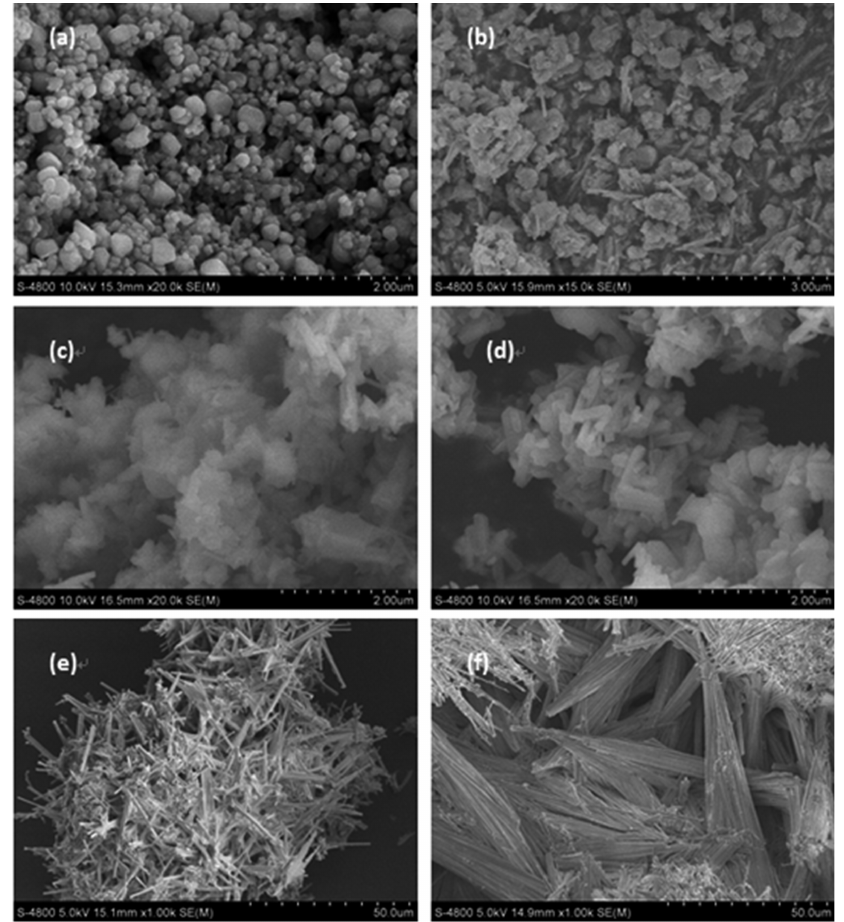
Figure 7: Evolution process of K 2 Ti 4 O 9 morphology. (a) raw material, (b) 700°C, heat preservation for 1 h, (c) 800°C, heat preservation for 1 h